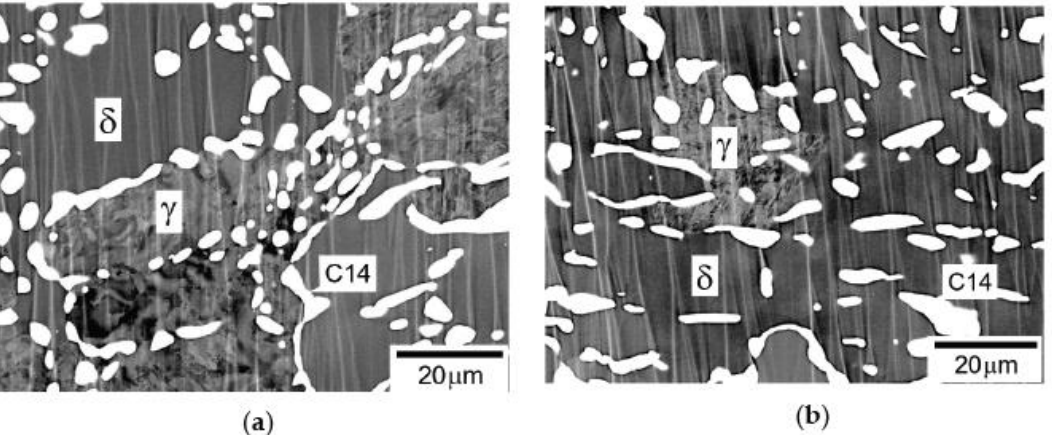
Figure 1. BSE images of the alloys studied: ( a ) 4 Hf alloy heat-treated at 1150 ◦ C for 48 h, ( b ) 5 Ta alloy heat-treated at 1100 ◦ C for 235 h. Vertical bright lines are originated from Ar milling. The regions denoted by γ was transformed to α -Fe during quenching from heat treatment temperatures.